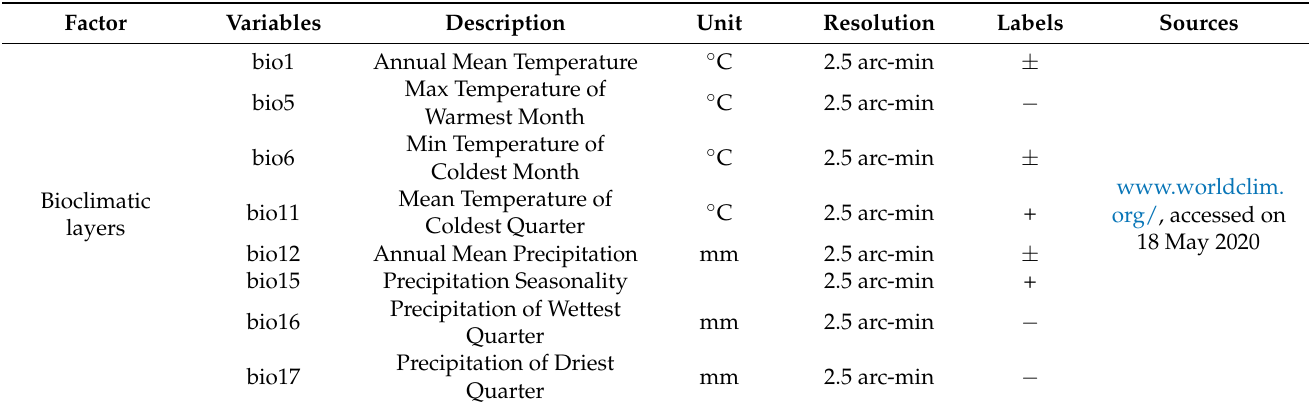
Table 1. The environmental factors used in the corresponding simulation (variables with labels of “+” for Valsa mali , “ − ” for Malus pumila Mill., and “*” for land